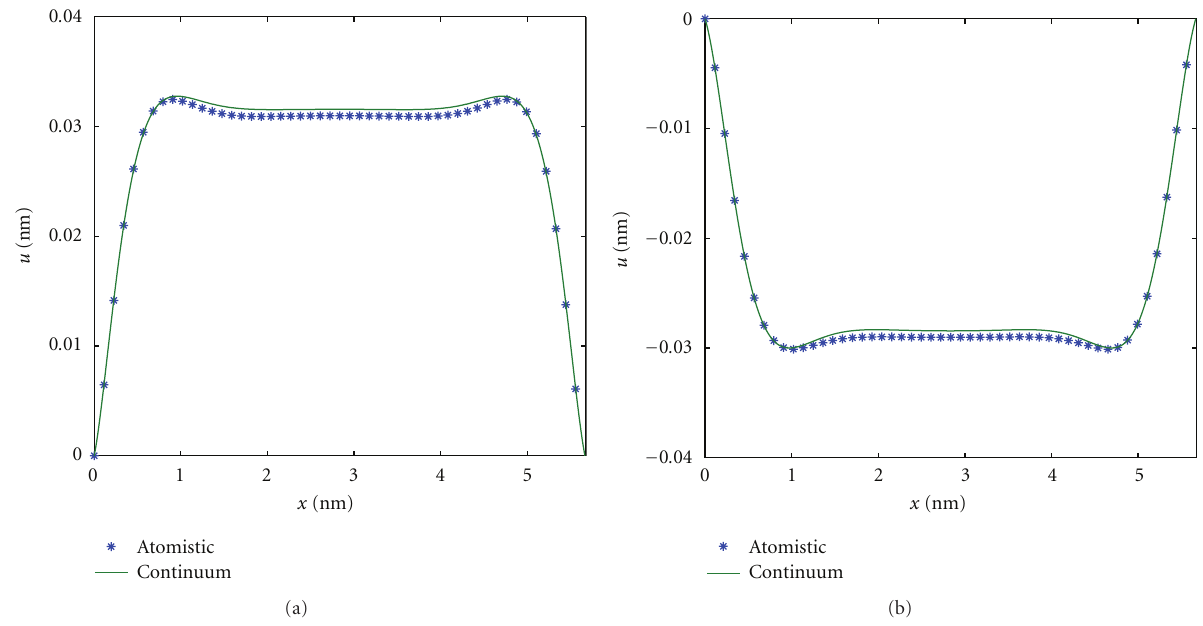
Figure 9: Results for an optimization with α = . 26nN nm, l = 6 . 8nm, and T = 0nN/nm. In (a), d = 0 . 31 nm. In (b), d = 0 . 37 nm. Note that the atoms on the edges of the layer, whose positions are prescribed, are not plotted because the continuum model does not describe the deflection of these